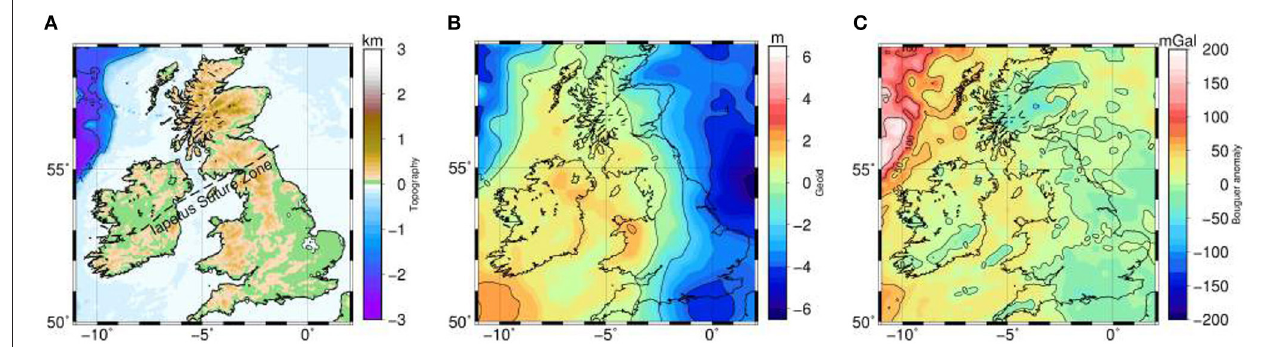
FIGURE 1 | Geophysical observables used as constraining data sets. (A) ETOPO2v2 2-min gridded global relief data (National Geophysical Data Center, 2006). Iapetus Suture Zone is indicated by dashed line. (B) Geoid anomalies from XGM2016 global model (Pail et al., 2018). The geoid signal has been filtered to remove long wavelengths ( > 4,000 km, degrees 2–9) of mostly deep origin. Isolines every 2 m. (C) Bouguer anomaly map computed from free-air satellite data (XGM2016) corrected by FA2BOUG software (Fullea et al., 2008) with the onshore data from Great Britain Land Gravity Survey and from the Dublin Institute for Advanced Studies and the Geological Survey of Northern Ireland. Isolines every 50